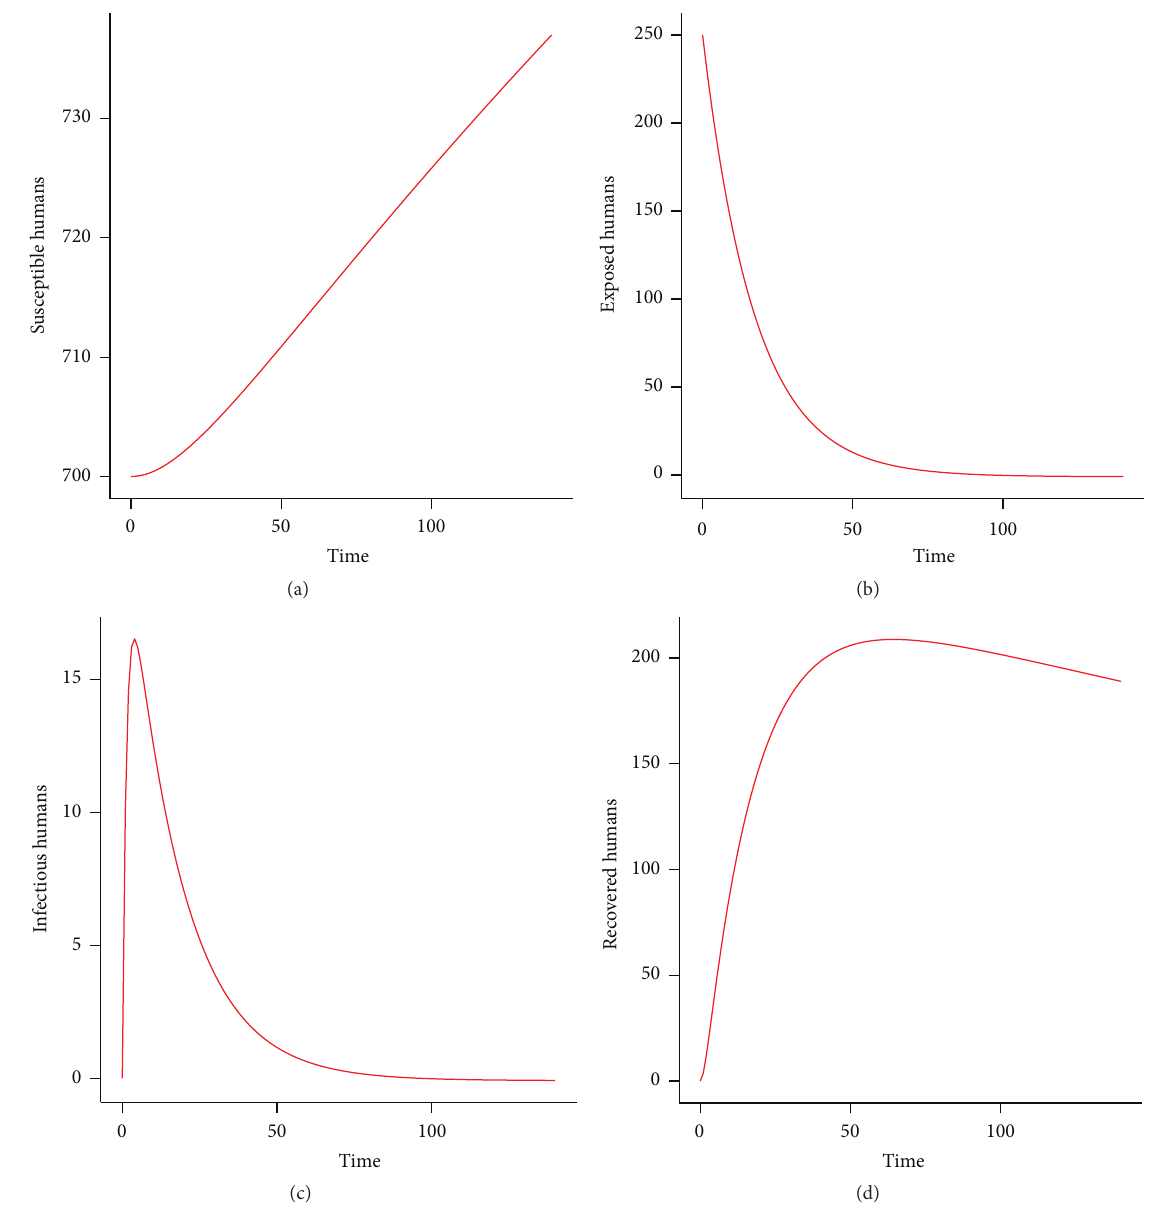
Figure 2: Simulations showing the dynamics of human population with intervention strategies for the endemic setting.